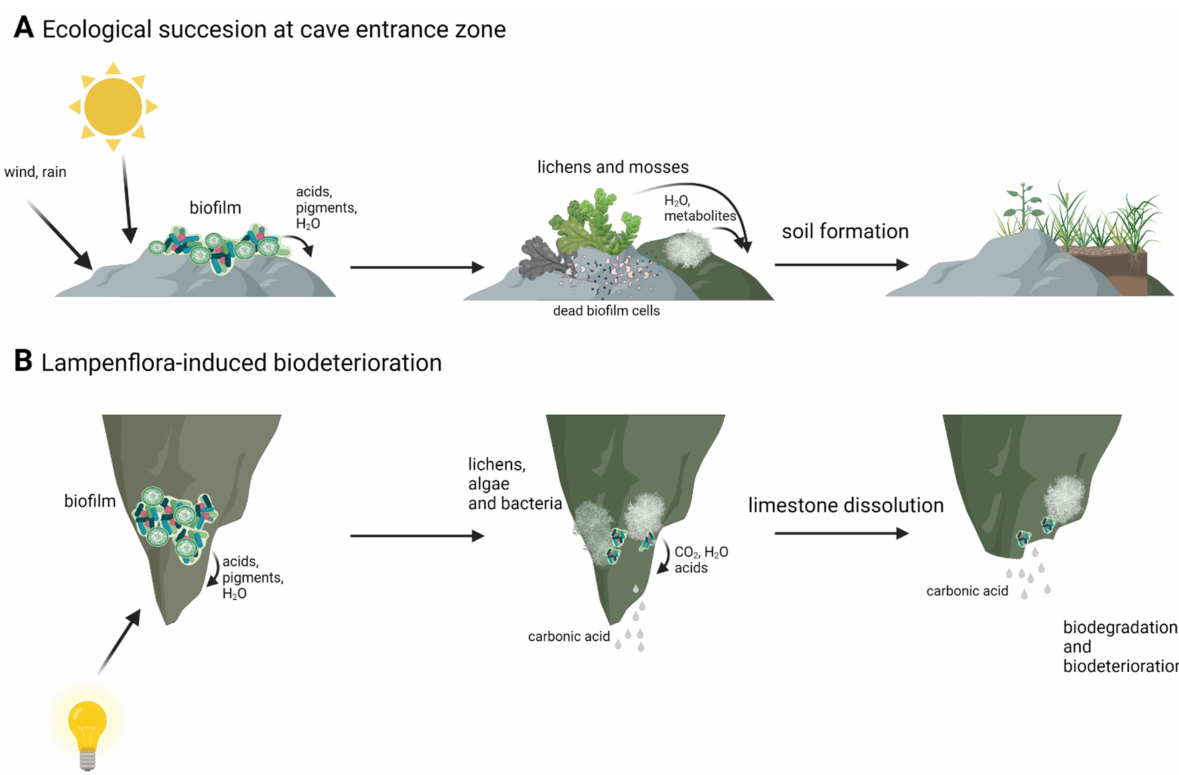
Figure 3. Differences between natural succession in cave entrance zone ( A ) and lampenflora-induced biodeterioration in cave dark zone ( B ). Created with BioRender.com (accessed on 4 January